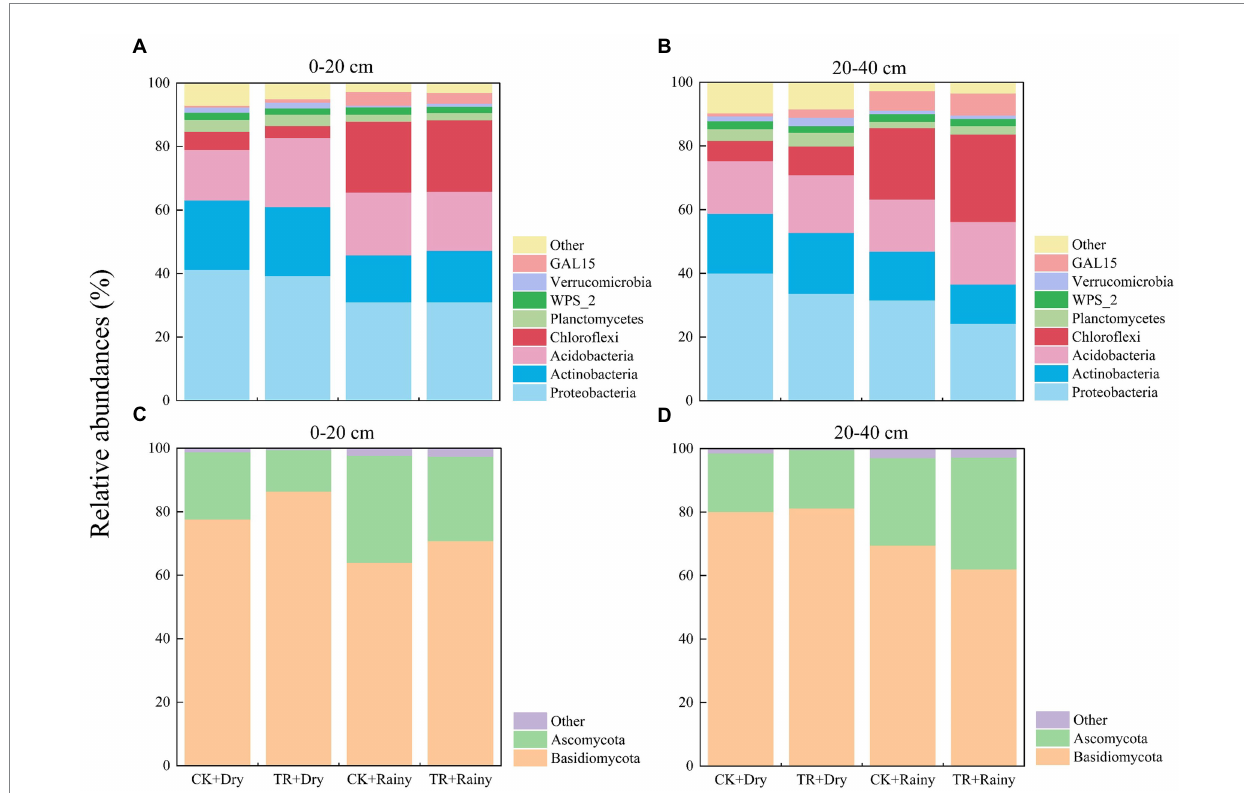
FIGURE 5 Relative abundances of the dominant bacterial (A,B) and fungal (C,D) phyla under different treatments. CK, control; TR, throughfall reduction treatment; Dry, the dry season; Rainy, the rainy season. Phyla accounting for ≥ 1% are shown while those <1% and unclassified group are integrated into